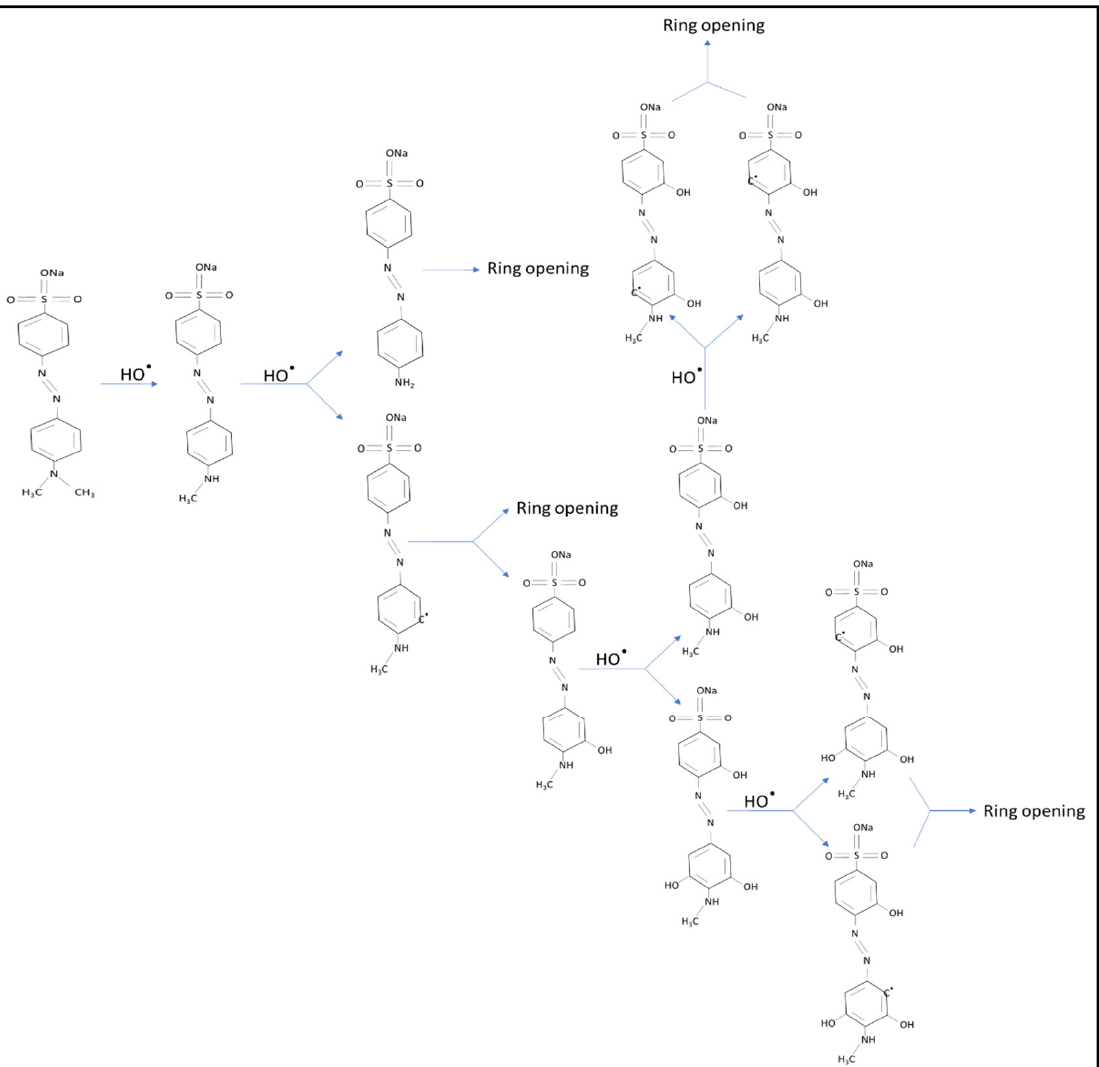
Figure 14. Illustrating the mechanism of the potential pathways for the photocatalytic degradation of MO by SiO 2 NPs, SiO 2 NPs defiled by Fe 3+ and/or Al 3+ ions, or Fe 2 O 3 and/or Al 2 O 3 deposited on the surface of SiO 2 NPs.